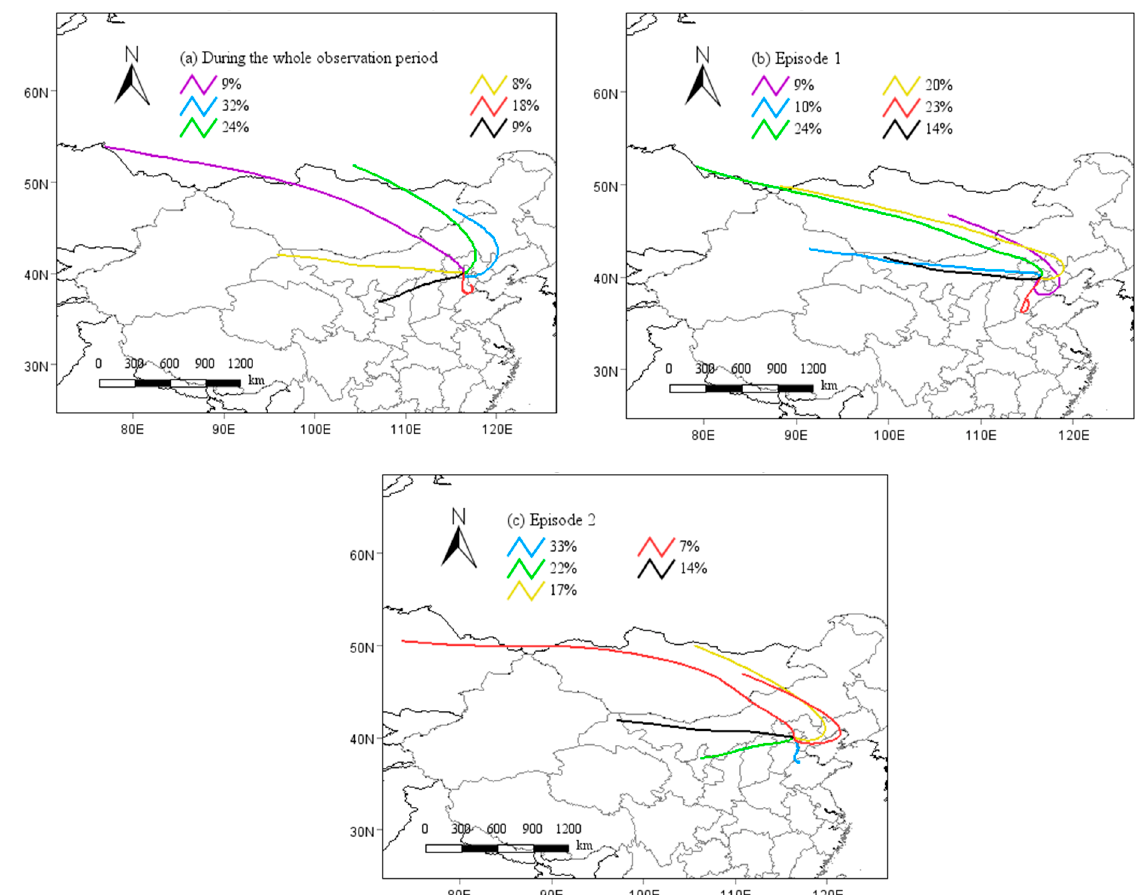
Figure 13. Backward trajectory clustering analysis in the study area: ( a ) during the whole observation period, ( b ) episode 1, ( c ) episode 2.